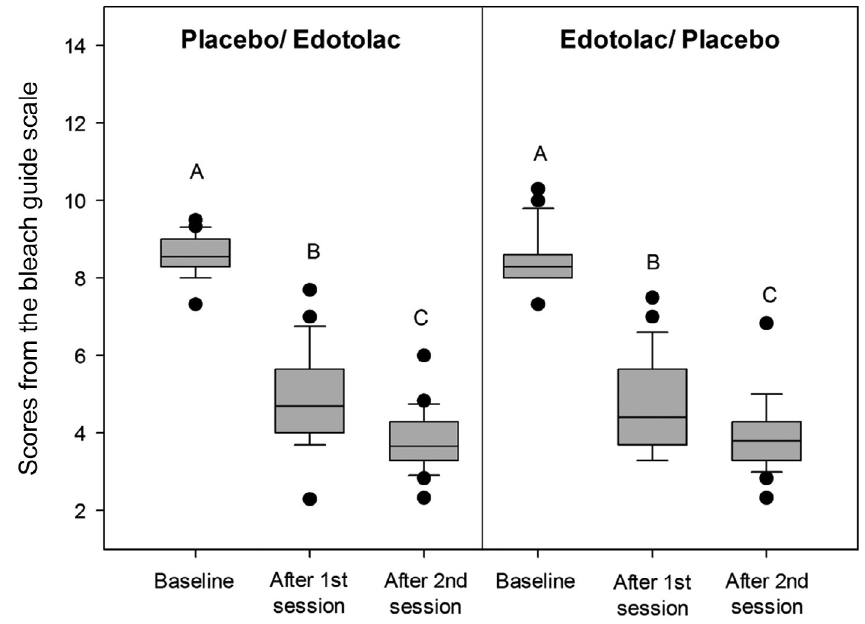
Figure 4- Scores from the bleach guide